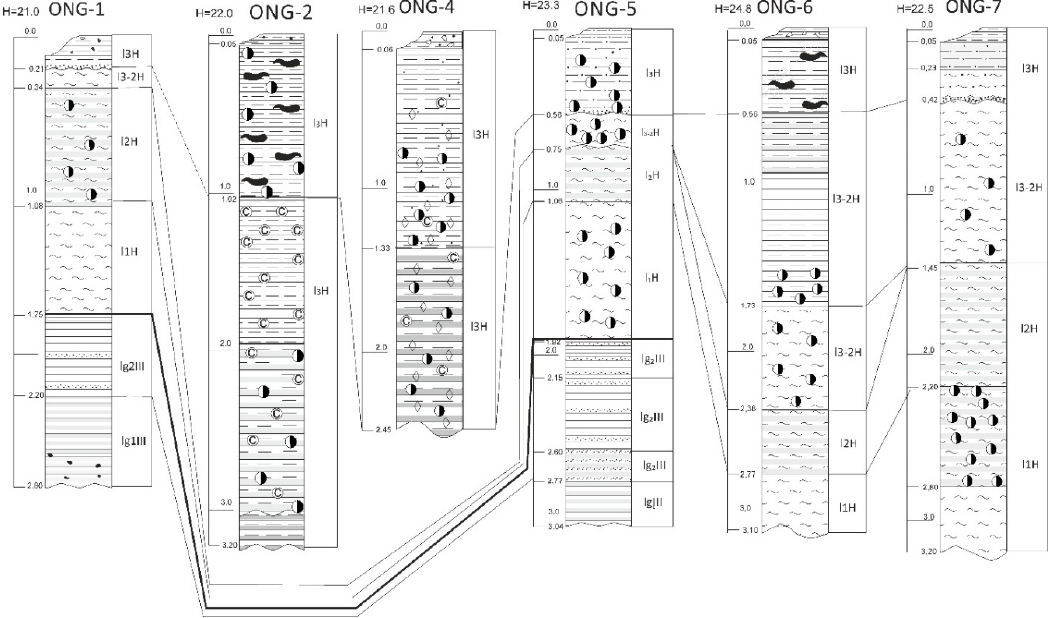
Figure 9. Correlation of Quaternary deposits from sediment cores in the Petrozavodsk Bay. Legend, see Figure 8. The bold line demonstrates the Late Pleistocene-Holocene boundary. The core ONG-3 was empty during the sampling of bottom sediments. The coring tube may have fallen on crystalline rocks or boulders.